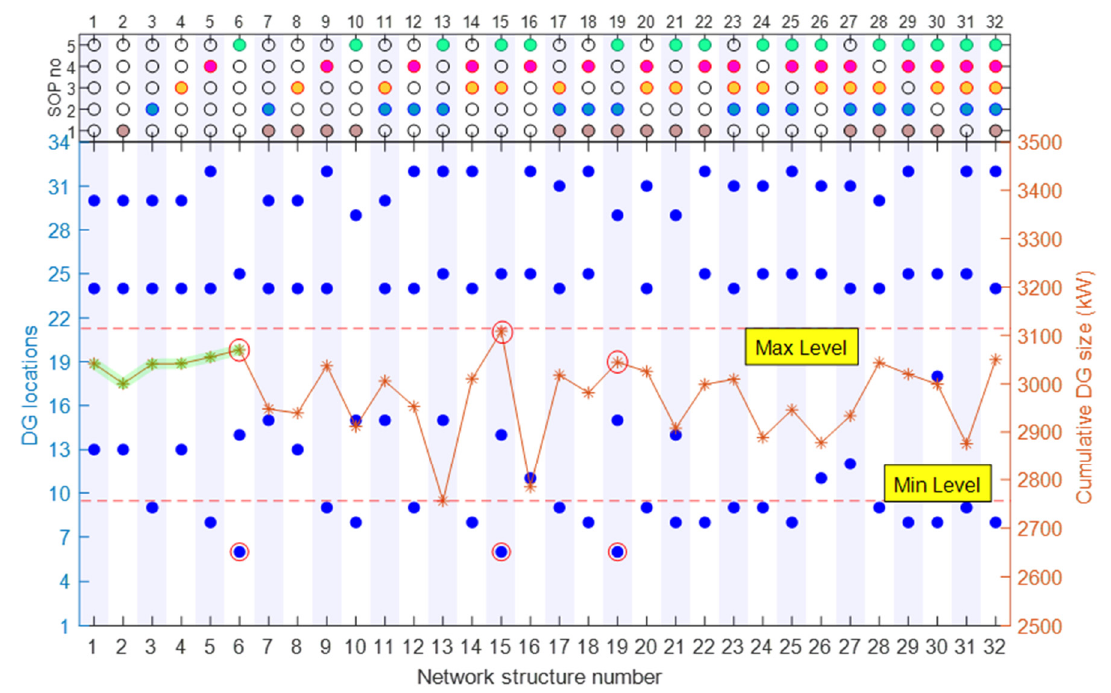
Figure 10. DG locations and the cumulative DG sizes for all the network structures.